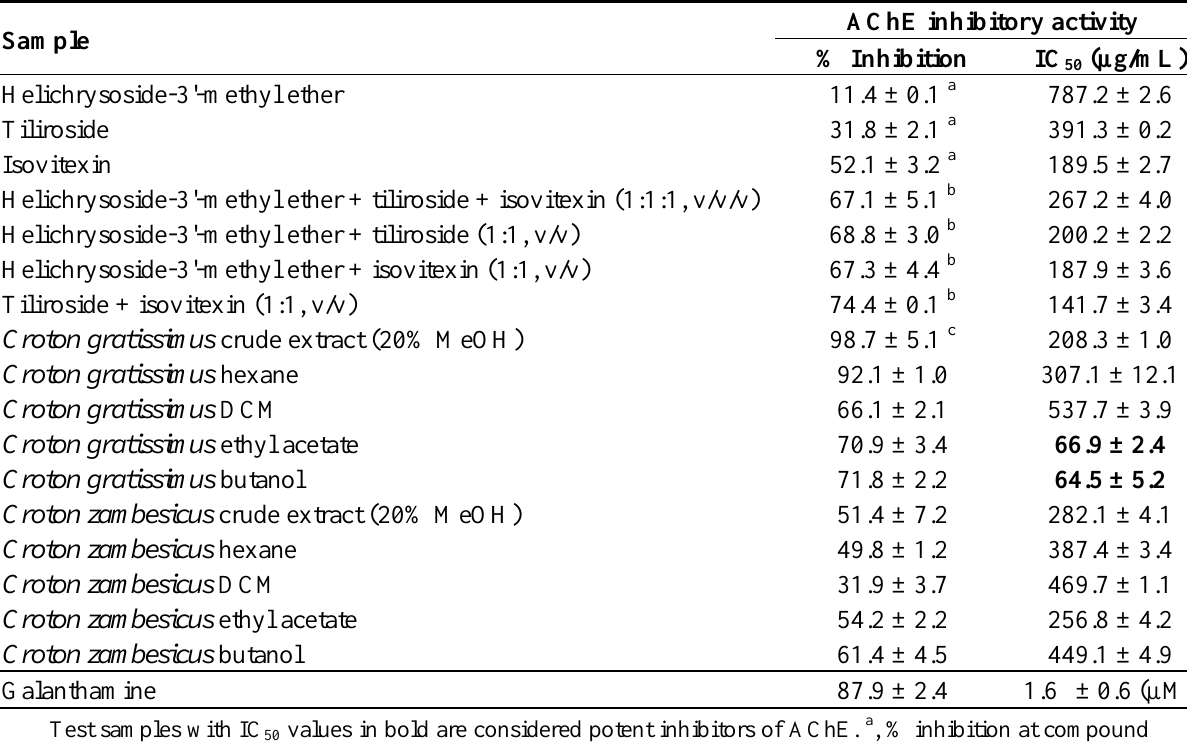
Table 2. AChE inhibitory activity (IC µg/mL) of the isolated compounds, compound 50 combinations, crude extracts and fractions from C. gratissimus and C. zambesicus . Values represent mean ± standard error (n =